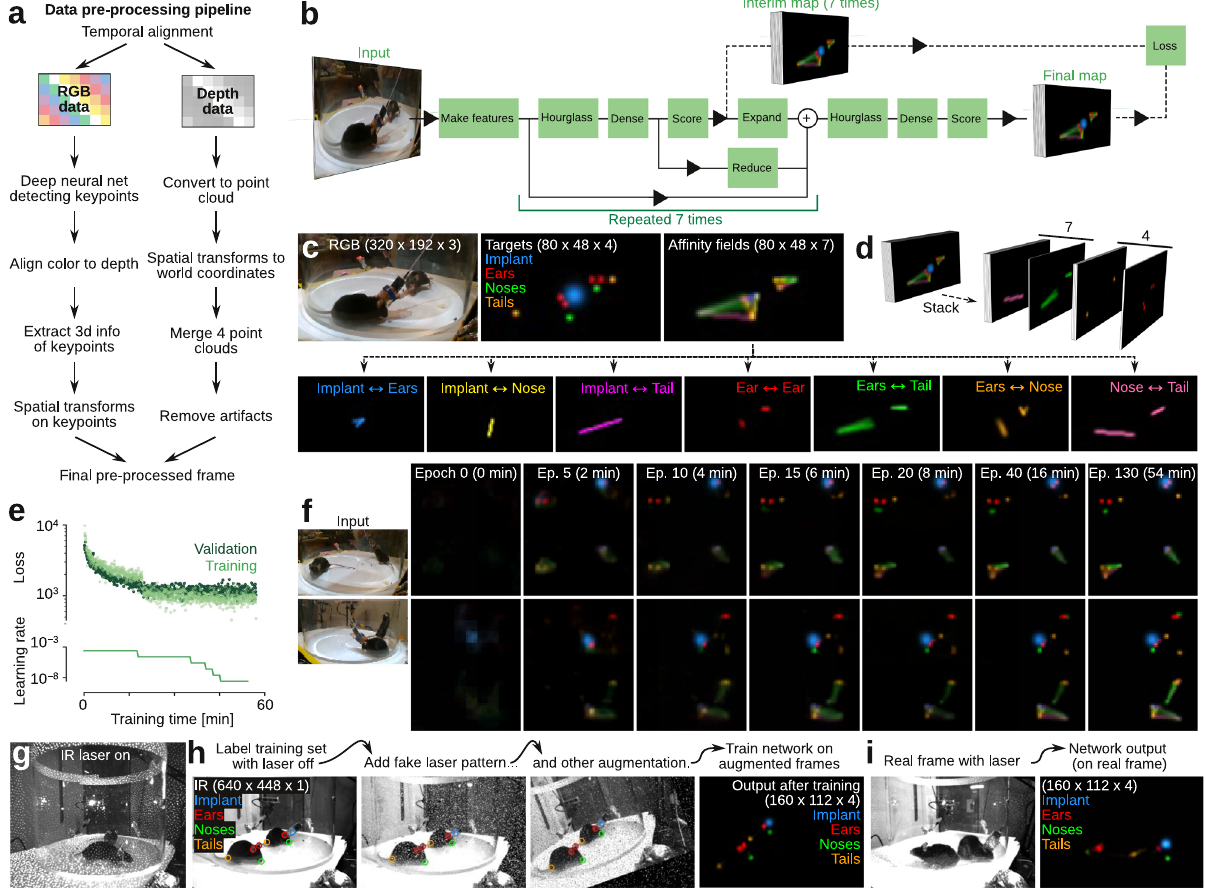
Fig. 2 Detection of body key-points with a deep convolutional neural network. a Work fl ow for pre-processing of raw image data. b The ‘ stacked hourglass ’ convolutional network architecture. Each ‘ hourglass ’ block of the network uses pooling and upsampling to incorporate both fi ne (high-resolution) and large-scale (low-resolution) information in the target prediction. The hourglass and scoring blocks are repeated seven times (seven ‘ stacks ’ ), such that intermediate key-point and af fi nity fi eld predictions feed into subsequent hourglass blocks. Both the intermediate and fi nal target maps contribute to the training loss, but only the fi nal output map is used for prediction. c Example training data for the deep convolutional neural network. The network is trained to output four types of body key-points (Implant, Ears, Noses, and Tails) and seven 1-D af fi nity fi elds, connecting key-points within each body. d Example of full training target tensor. e Convergence plot of example training set. Top, loss function for each mini-batch of the training set (526 images) and validation set (50 images). Bottom, learning rate. Network loss is trained (plateaued) after ~ 60 min. f Network performance as function of training epoch for two example images in the validation set. Left, input images; right, fi nal output maps for key-points and af fi nity fi elds. g In an infrared frame (under infrared illumination), the clear view of the mice is ‘ obstructed ’ by the infrared laser dot pattern. h Example labeled training frame (with the laser turned off), showing the augmentation strategy of applying a probabilistically generated ‘ fake ’ laser dot pattern during training. i Example network output of the trained network on a ‘ real ’ infrared frame with the infrared laser turned